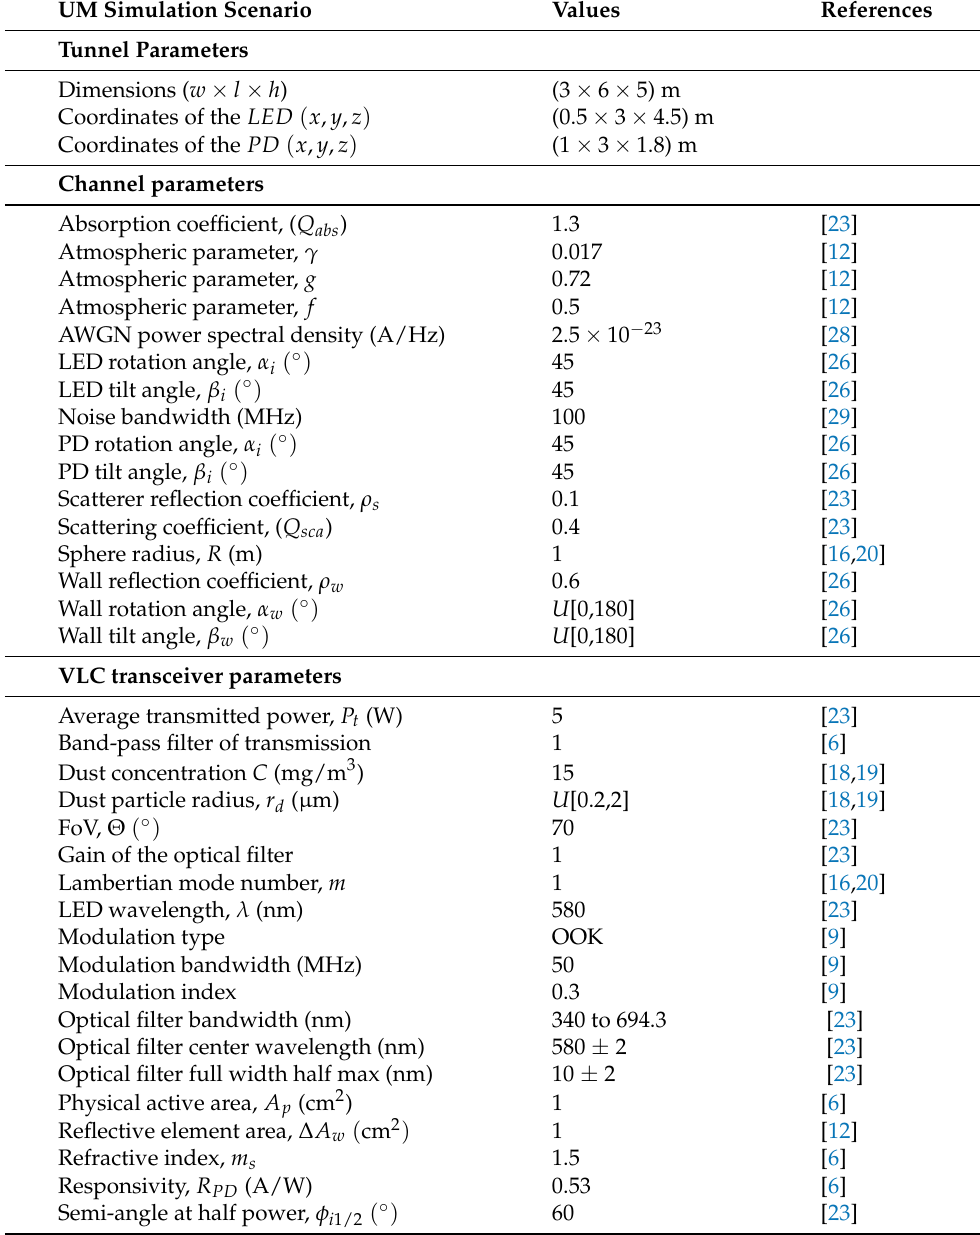
Table 1. UM-VLC system simulation